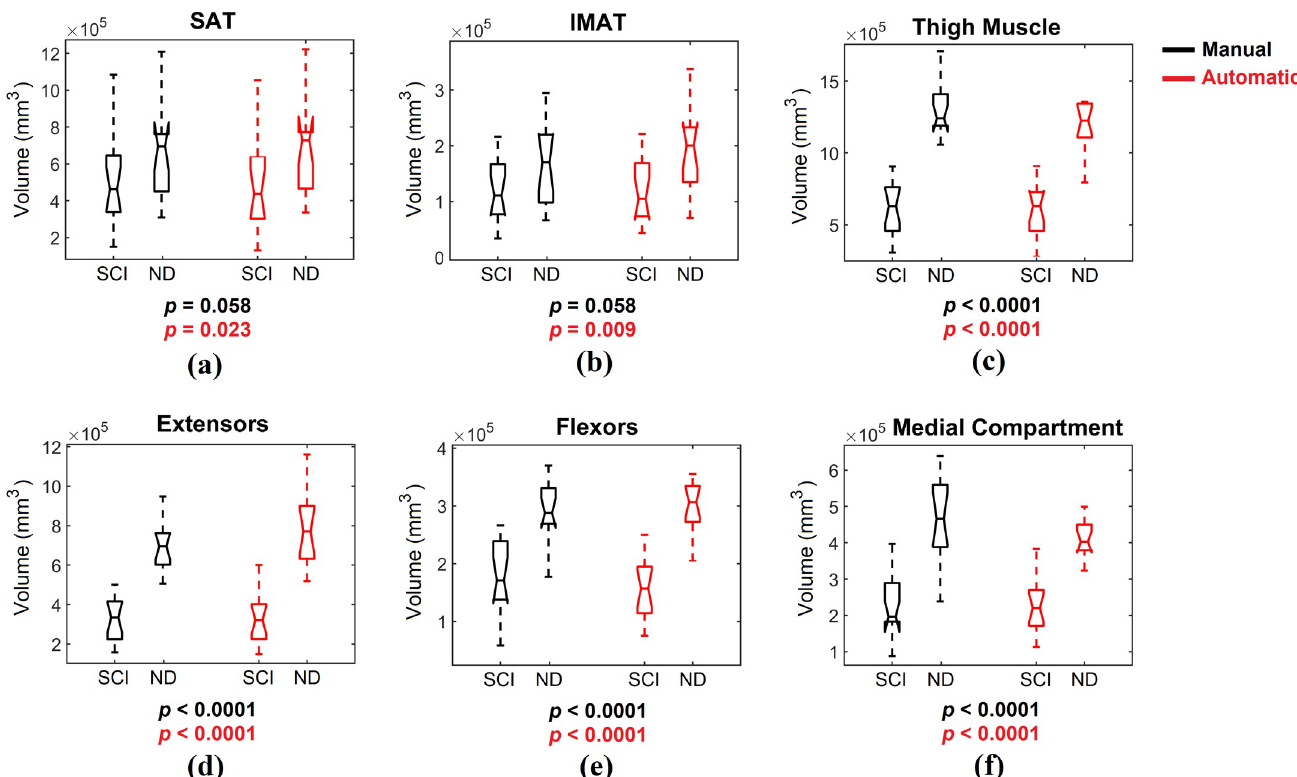
Fig 6. The boxplot representation of the calculated volumes and ratios for manual (black) and automatic (red) segmentation results. (a) Extensor volume; (b) Flexor volume; (c) Medial volume; (d) IMAT volume; (e) SAT volume; and (f) Total muscle volume.